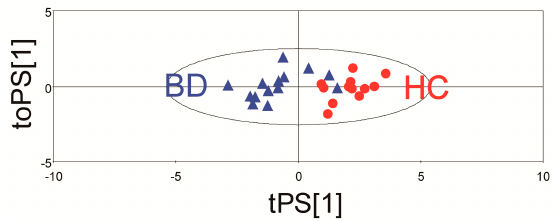
Figure 4. The score plot of the orthogonal partial least squared-discrimination analysis (OPLS-DA) in the independent set on the basis of 10 potential metabolic biomarkers. The blue triangles and red circles denote Behcet’s disease (BD) and healthy controls (HC), respectively.